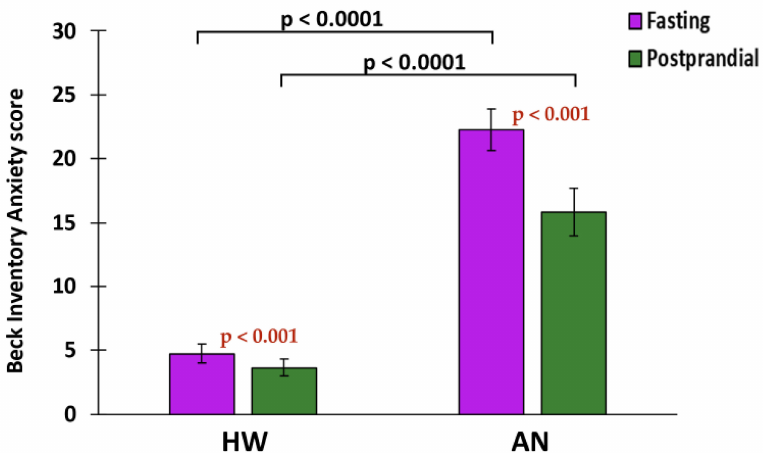
Figure 6. Bar plots for anxiety level at fasting (purple) and postprandial (green) timepoints in HW and AN.